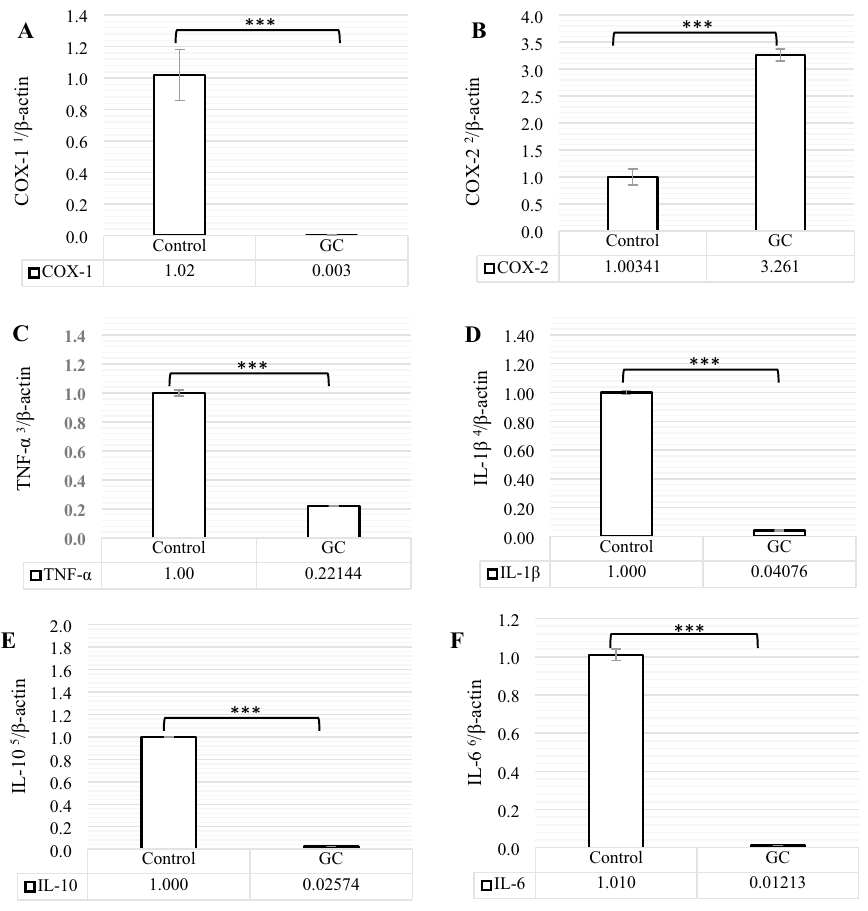
Figure 1. The comparison of COX-1 ( A ), COX-2 ( B ), TNF-α ( C ), IL-1β ( D ), IL-10 ( E ), and IL-6 ( F ) mRNA expressions between control and GC (Glucocorticoid Fluticasone, 2 ppm). Different statistical marks are significant (*P ≤ 0.05, **P ≤ 0.01, and ***P ≤ 0.001) according to the Dunnett’s test as a comparison procedure. COX-1, COX-2, TNF-α, IL-1β, IL-10, and IL-6 mRNA data were normalized by β-actin. (1)